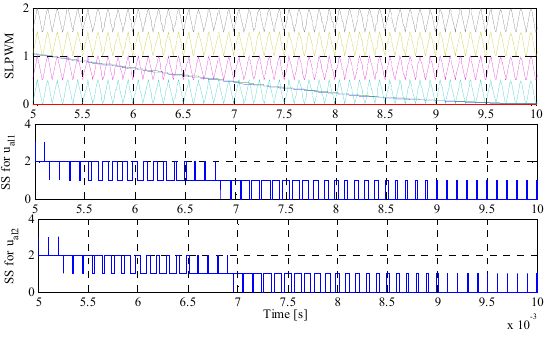
Figure 6. A typical shifted ‐ level PWM for proposed lower modulation function with parameter changes.